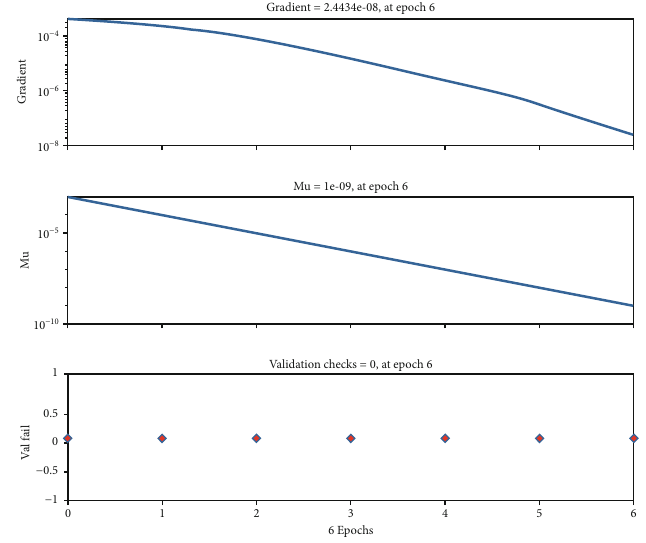
Figure 27: Training data for the DNN-current regulator.